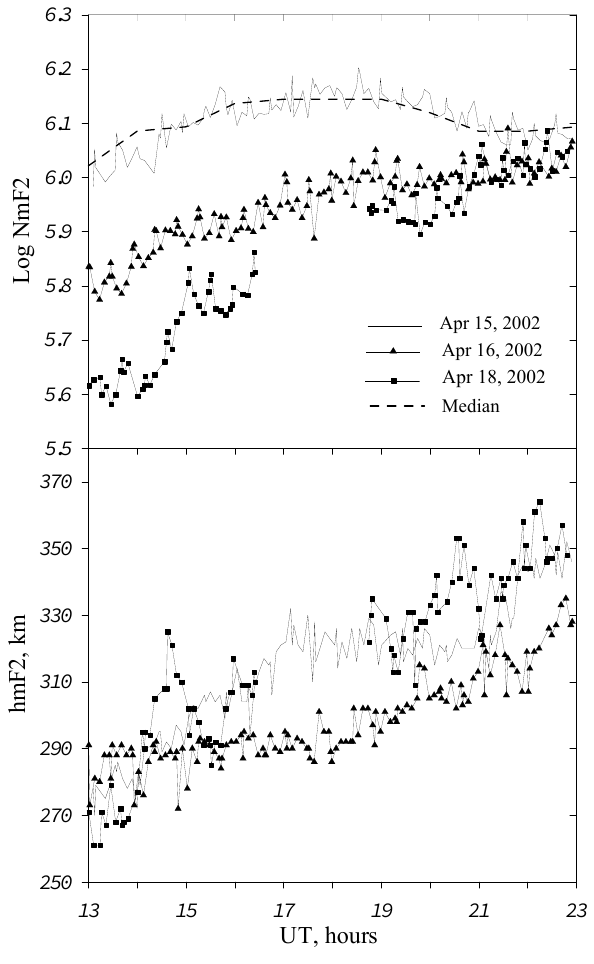
Fig. 5. Fig. 5. Millstone Hill ISR observations of Nm F2 and hm F2 diurnal variations for the negative Q-disturbance of 16 April 2002, a usual negative storm day of 18 April 2002, and a reference day of 15 April 2002, which coincides with the monthly median. Note that hm F2 are lower than the reference values for the Q-disturbance day and hm F2 are higher than the reference level for the disturbed day of 18 April